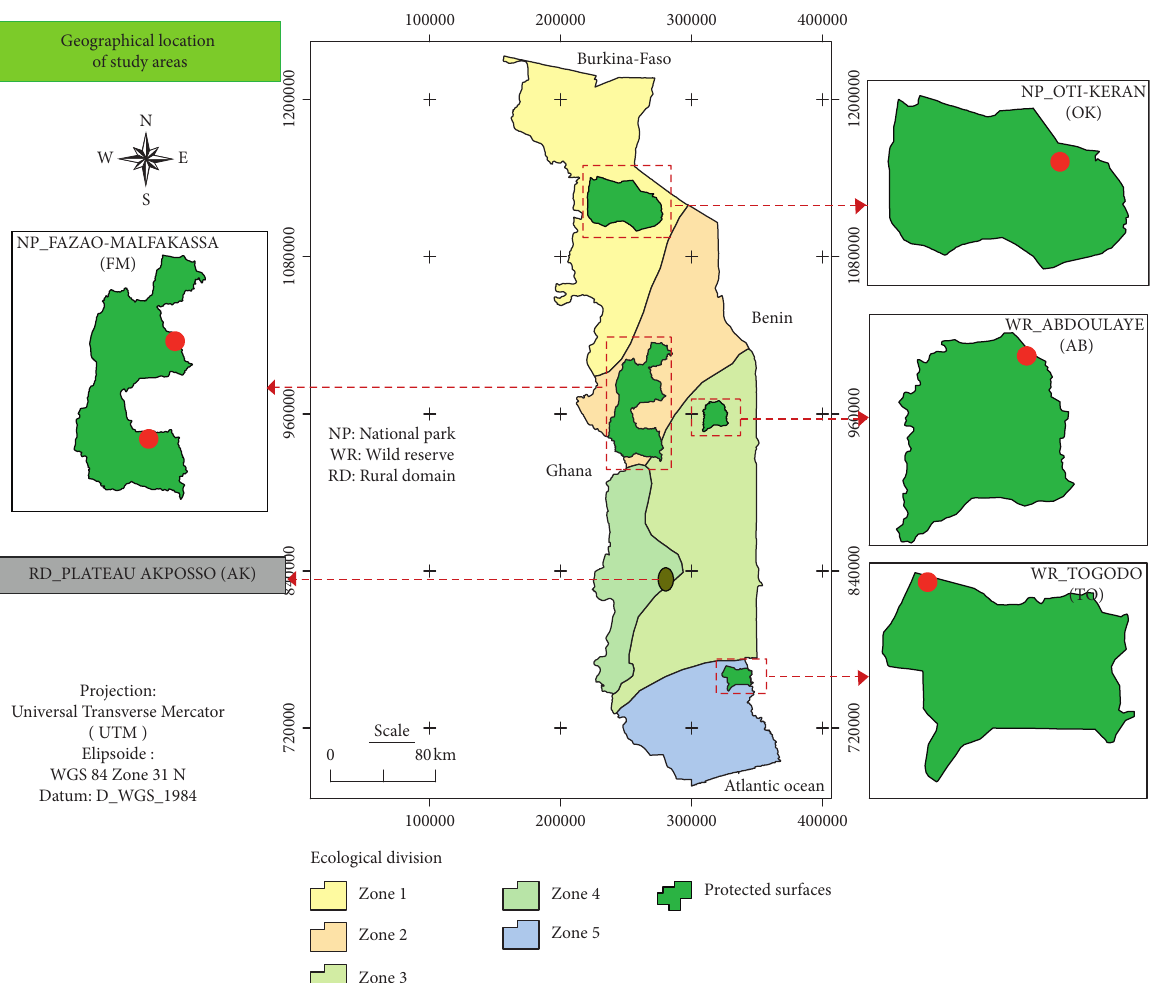
Figure 1: Location of analysed populations of Pterocarpus erinaceus in Togo from north to south: the National Park of Oti-Keran (OK), National Park of Fazao-Malfakassa (FM), Wildlife Reserve of Abdoulaye (AB), Rural Domain of Plateau Akposso (AK), and Wildlife Reserve of Togodo